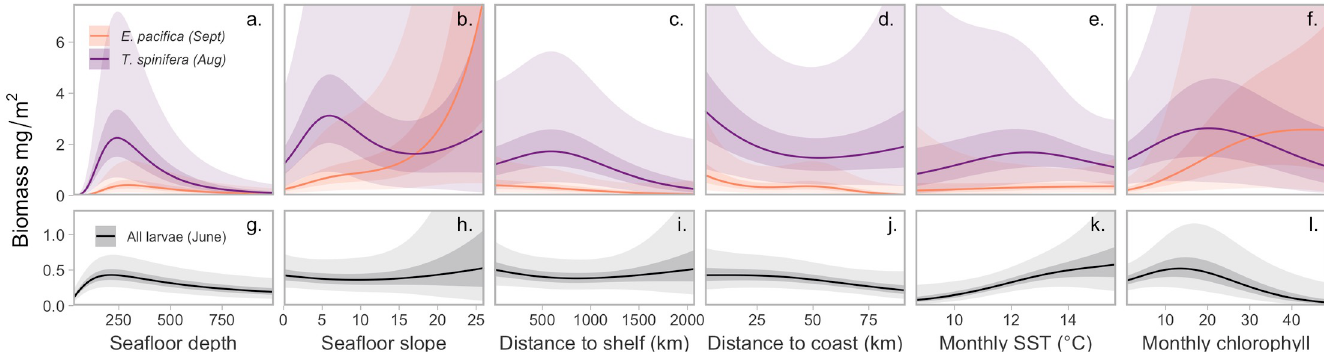
Fig 2. Conditional effects of each of the fixed effects (x-axis) included in the full models, illustrating differences in peak biomass density (y-axis) between species (top row) and for total larval biomass (bottom row). The height of each curve represents the predicted density in the month with the highest estimated biomass densities for each group, at the weighted mean occupied conditions of all other covariates, and at the mean of spatiotemporal modelled effects. The shapes of these curves were not allowed to interact with other covariates. Lines represent means and shaded ribbons represent 50% CIs, with the most lightly shaded area representing 95%